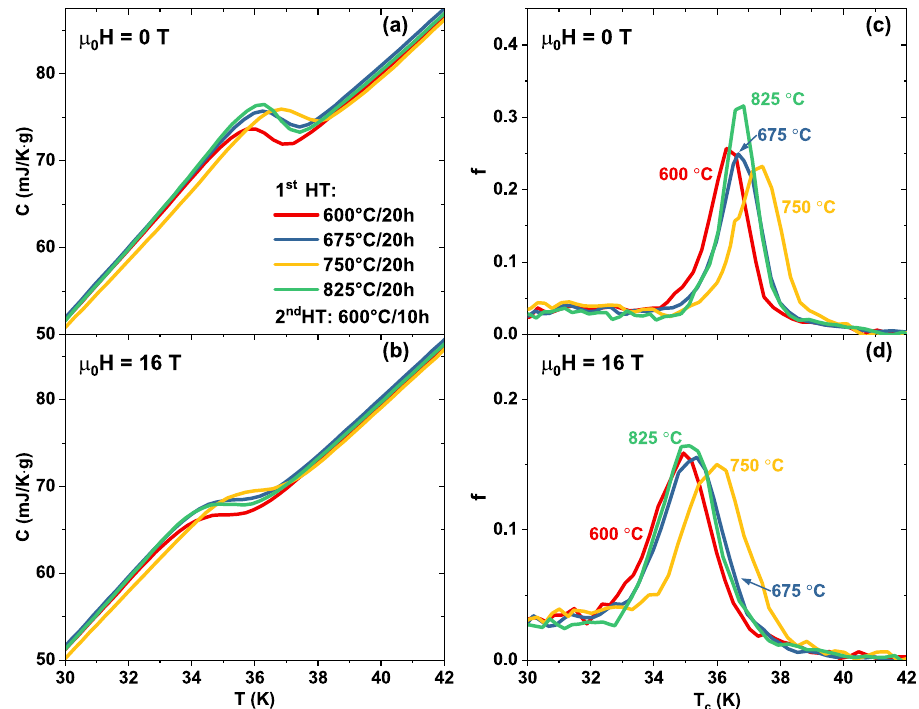
Figure 2. Specific heat transitions and T c -distribution of the K-Ba122 samples prepared varying the 1st HT temperature. ( a , b ) magnification of the main superconducting transitions at 0 and 16 T. ( c , d ) correspondent T c - distributions calculated as explained in the text.